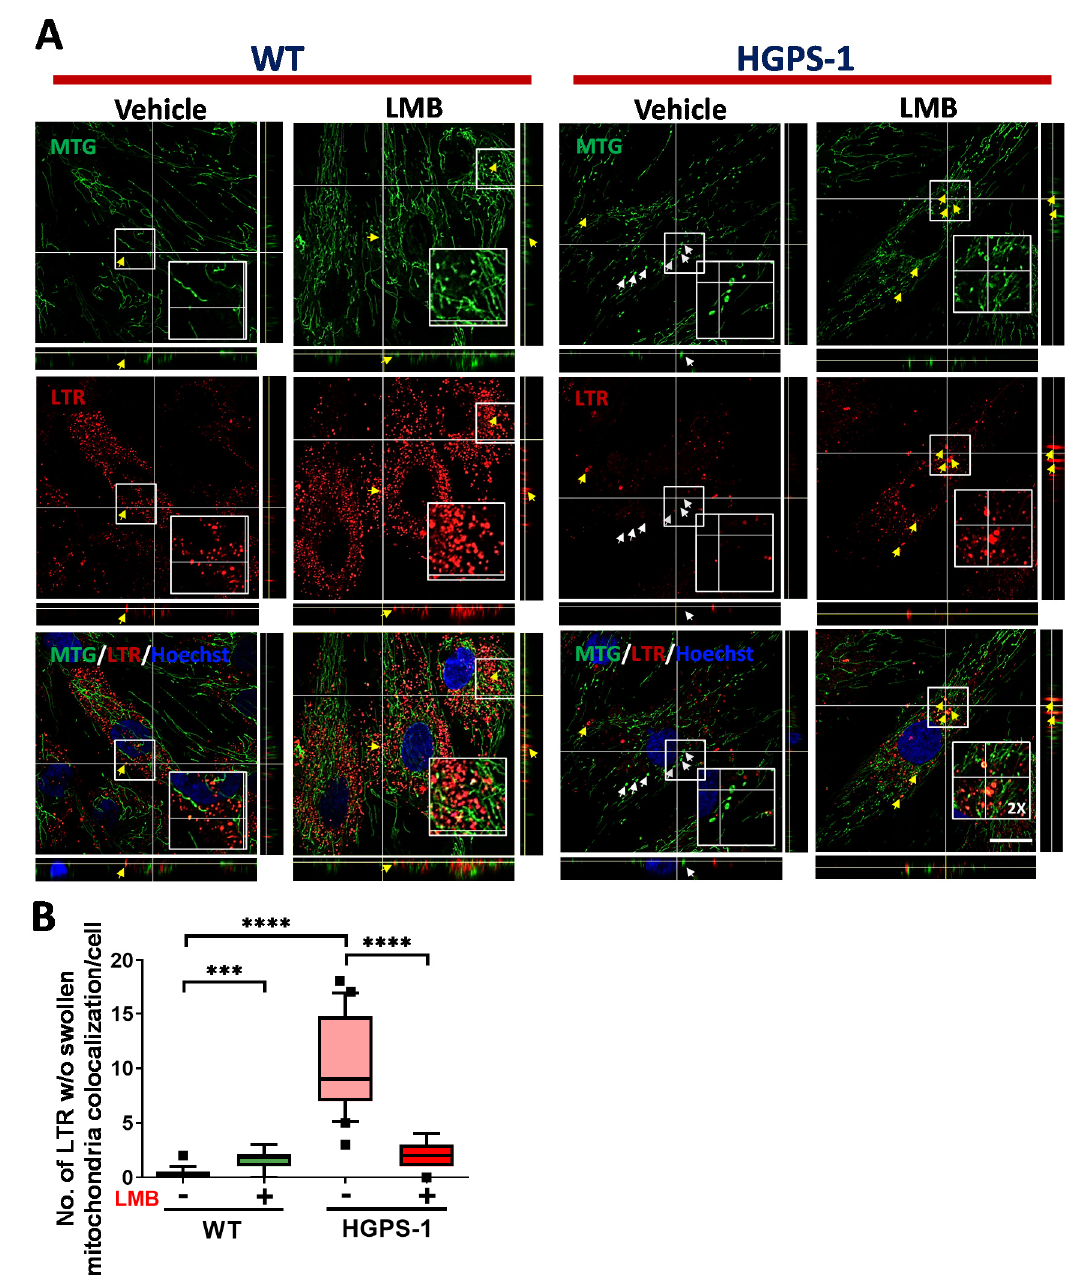
Figure 7. The lack of colocalization of lysosomes with swollen mitochondria in HGPS-1 cells is alleviated by exposure to LMB. ( A ) WT and HGPS-1 fibroblasts were grown on coverslips and incubated with 1 nM LMB or the vehicle alone for 3 days prior to being subjected to cell live analysis. Cells were simultaneously stained with Lysotracker, MTG and Hoechst to visualize the lysosomes, mitochondria, and nuclei, respectively. Typical orthogonal views of the images from three separate experiments are shown. Yellow arrows point at the colocalization between swollen mitochondria and lysosomes, and white arrows point at swollen mitochondria (w/o) colocalization with lysosomes; scale bar 10 µ m. ( B ) The number of swollen mitochondria not colocalized with lysosomes was quantified from three independent experiments. Data is shown on a box and whiskers graph (percentile: 10–90, n = 60 cells per condition). The p values denoted significant differences (nonparametric Mann–Whitney test; *** p < 0.001; **** p <